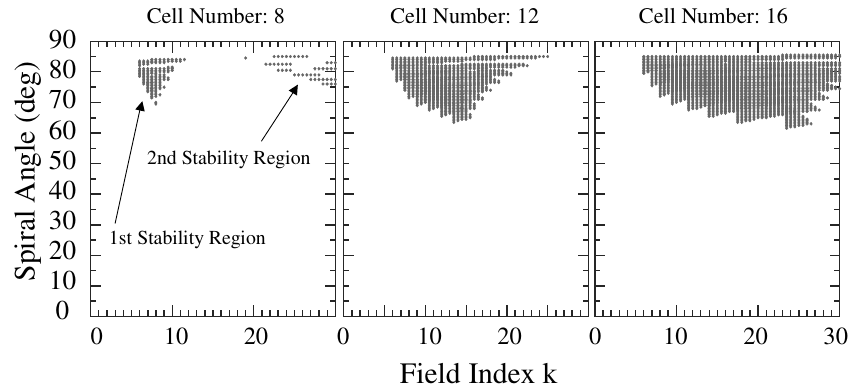
FIG. 6. Required spiral angles for 8, 12, 16 cells to fulfill the condition for orbit excursion of 1 m or less.